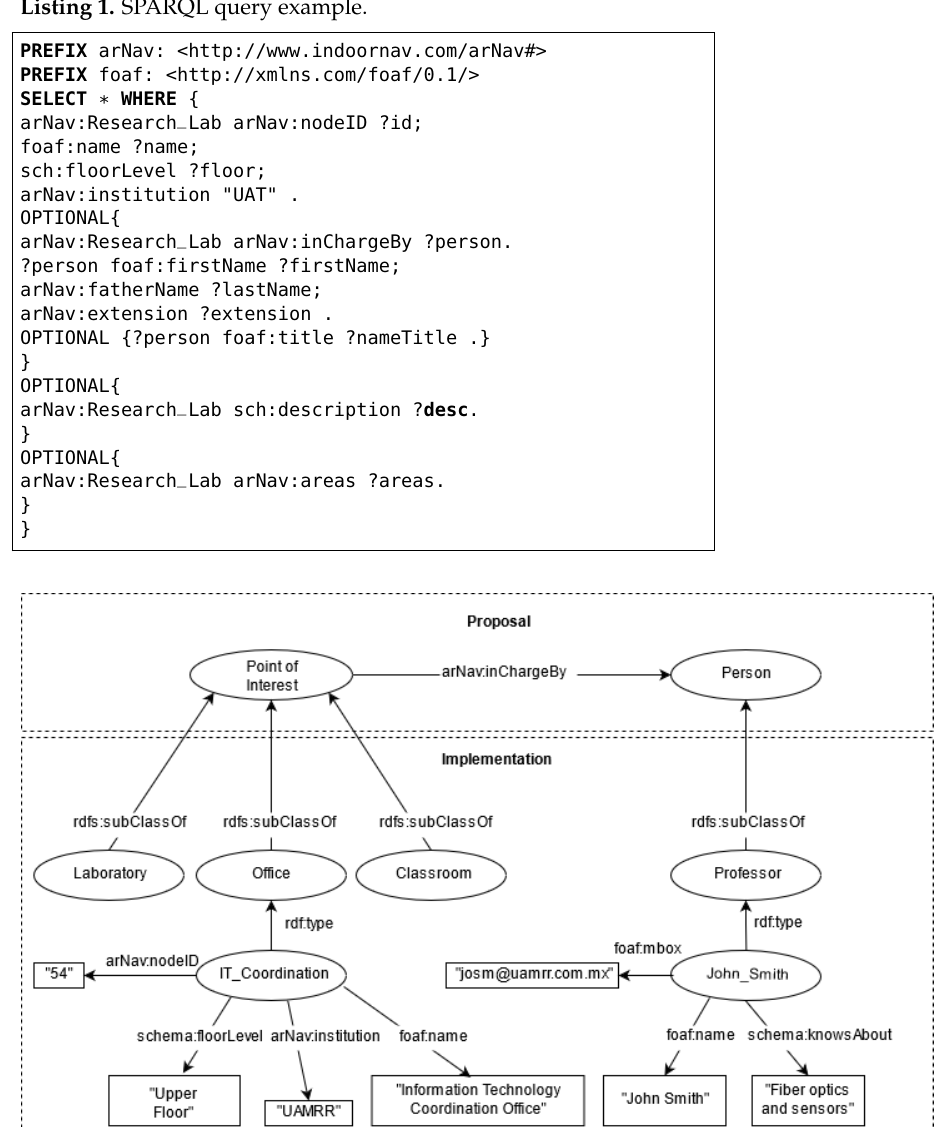
Figure 2. Designed ontology for contextual information in the academic